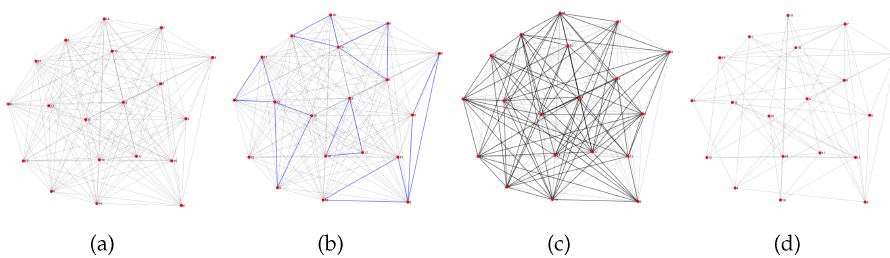
Figure 6. Illustrative process of outlier elimination using CCI to filter incorrect match pairs: ( a ) input original view-graph, where red vertices indicate images and gray edges are match pairs; ( b ) procedure of cycle extraction on view-graph, where only some sample cycles are highlighted by blue lines; ( c ) CCI infers incorrect edges, which are highlighted by black lines; and ( d ) filtered view-graph after eliminating incorrect